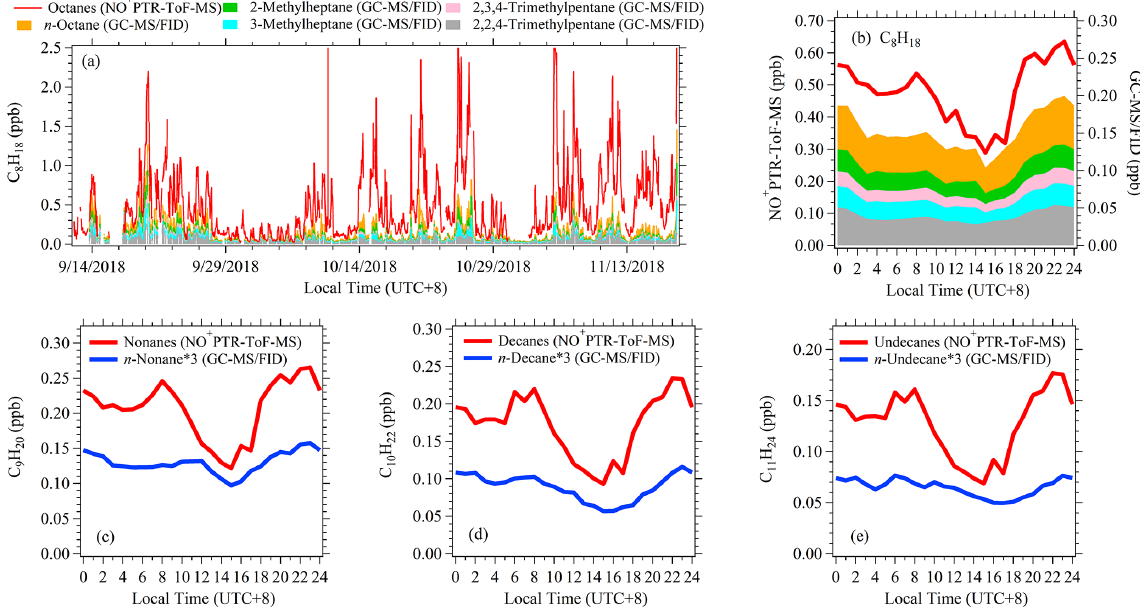
Figure 5. Comparisons of times series and diurnal variations of alkanes measured using NO + PTR-ToF-MS and GC-MS/FID in PRD. (a) Time series of C8 alkanes measured using NO + PTR-ToF-MS, and C8 n -alkane and four branched isomers measured using GC-MS/FID. (b) Diurnal variations of C8 alkanes. (c–e) Diurnal variations of C9–C11 alkanes measured using NO + PTR-ToF-MS and C9–C11 n -alkanes measured using GC-MS/FID.